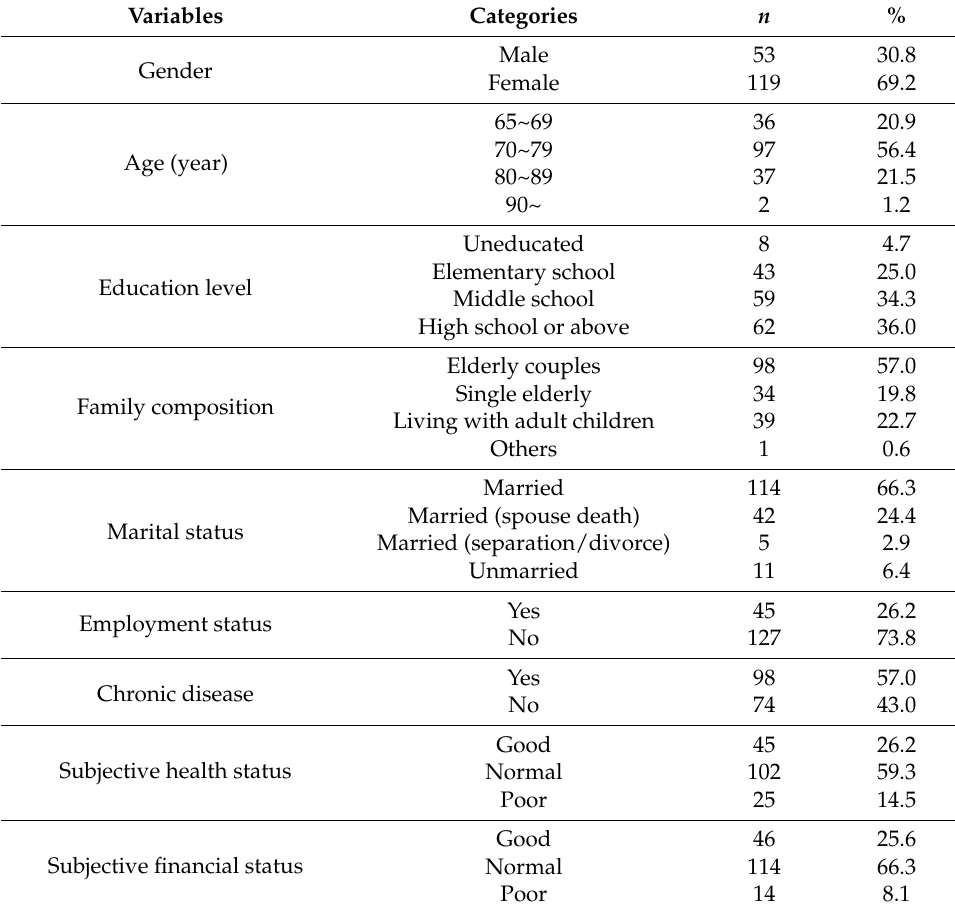
Table 1. General characteristics of the